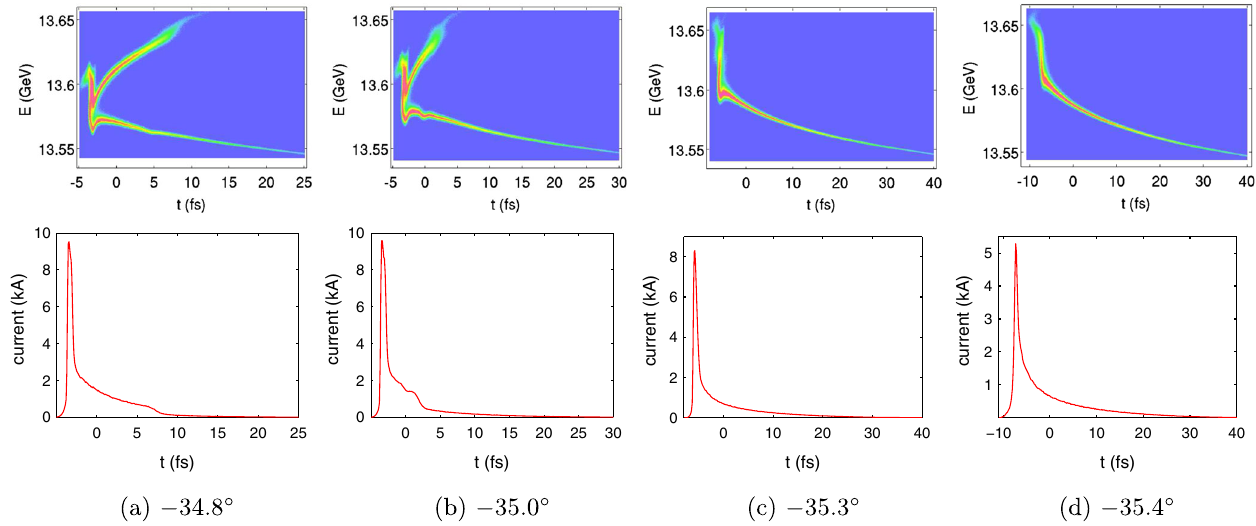
FIG. 4. E LEGANT tracking results of electron bunch distribution in the longitudinal phase space (upper) and its current profile (lower) at the LCLS undulator entrance for different L2 rf phases. The L1S rf phase is − 27 °. L1X is with the phase of − 180 ° and amplitude of 15